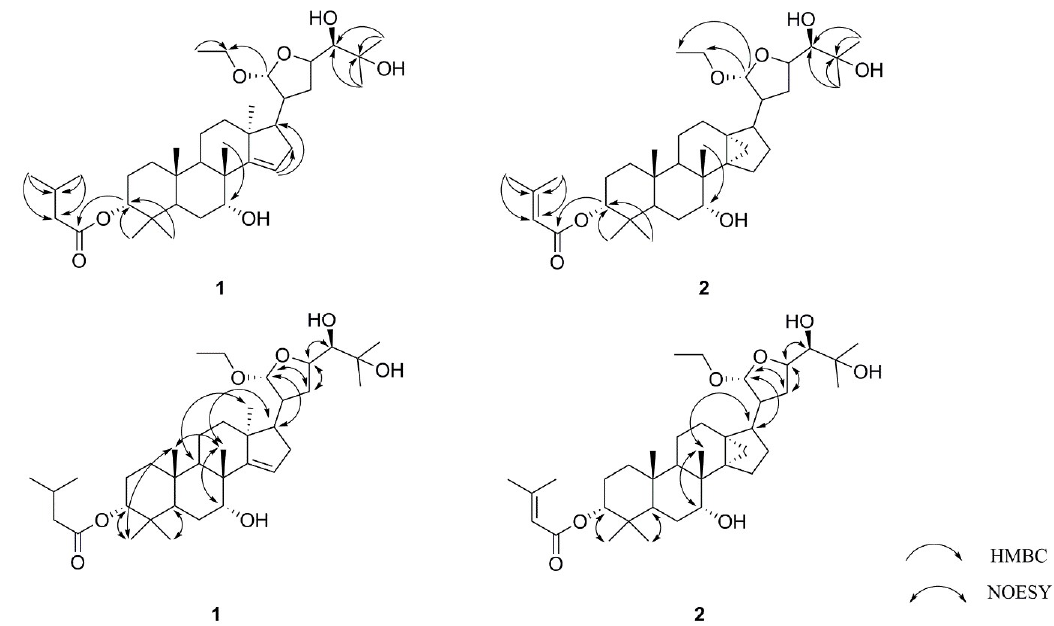
Figure 2. Key HMBC and NOESY correlations of compounds 1 – 2.